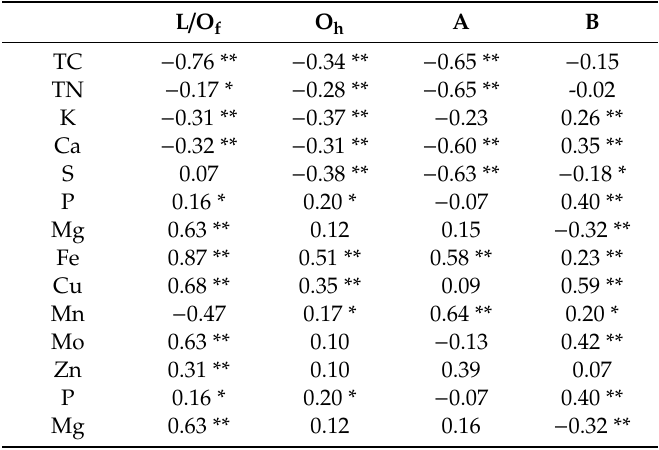
Table 1. Spearman correlation coe ffi cients on the association between nutrient elements concentration and U concentration for the four horizons (L / O f , O h , A, and B). Significant di ff erences were indicated by ** p ≤ 0.01, * p ≤ 0.05. L / O f